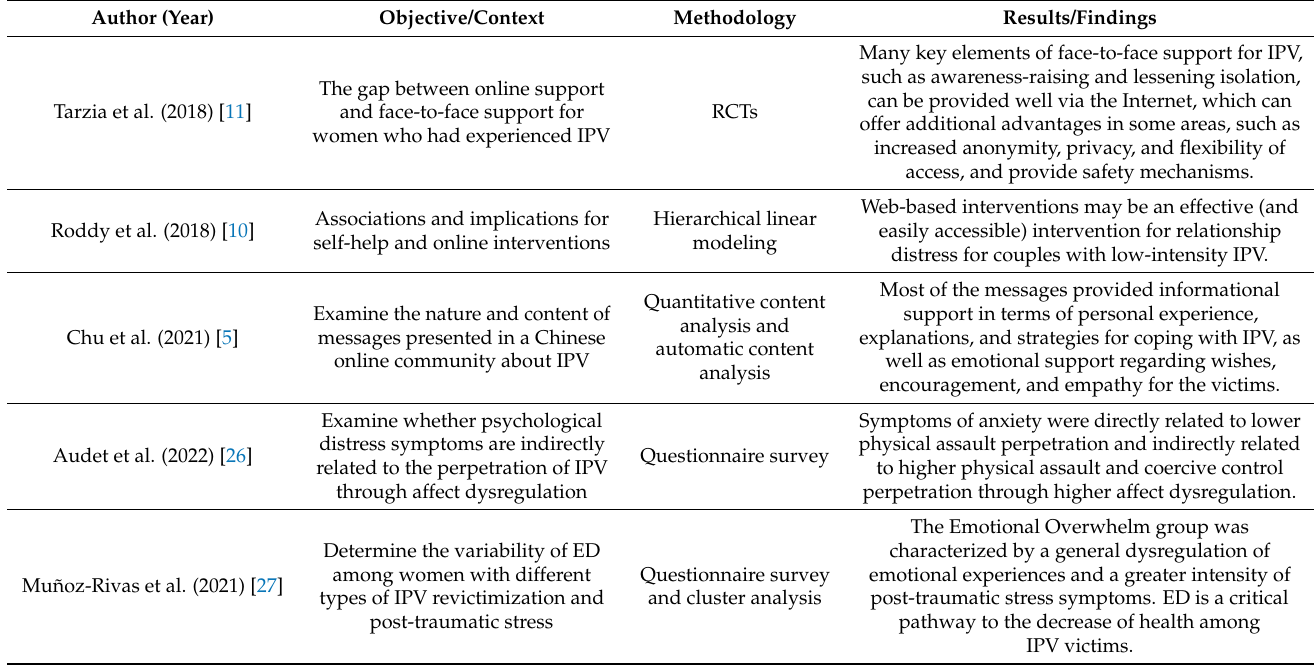
Table 1. Summary of the related